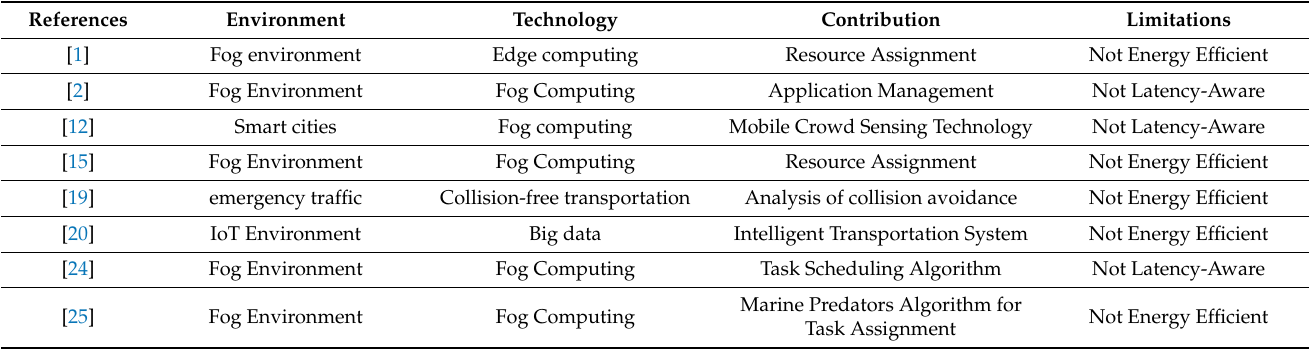
Table 1. The analysis of existing